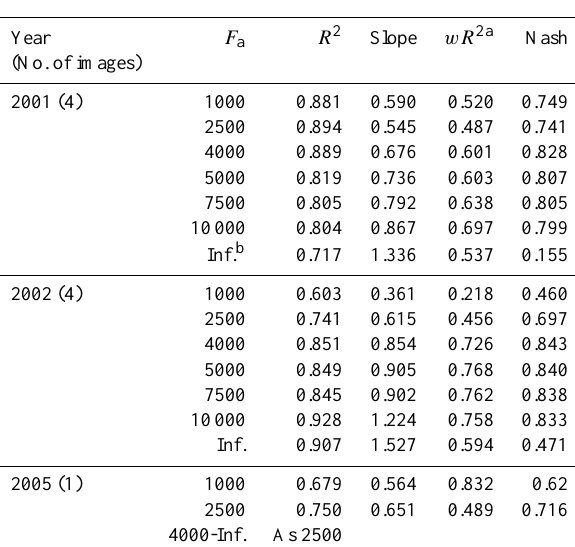
Table 2. Model performance for different fracture area thresholds ( F a , m 2 ) .